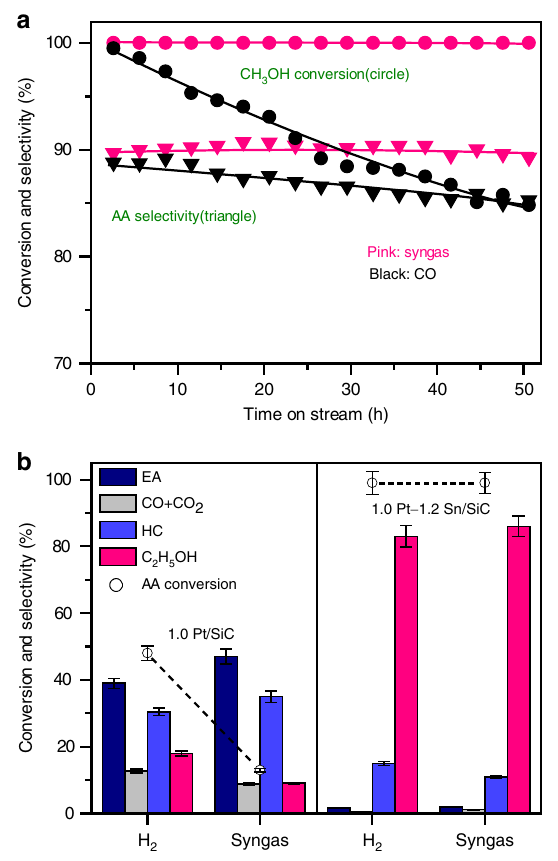
Fig. 5 Catalyst compatibility in syngas stream. a Catalytic performances of H-MOR – DA – 12MR for methanol carbonylation in CO and syngas streams. AA: acetic acid. Reaction conditions: H-MOR – DA – 12MR, 1.0 g; P = 5.0 MPa; T = 583 K; F (CH = 1.48 mmol h − 1 ; F (95%CO – 5%Ar) or 3 OH) F (48%CO – 48%H – 4%Ar) = 12 or 24 mL min − 1 . b Catalytic performances 2 of Pt/SiC and Pt – Sn/SiC for acetic acid hydrogenation in H 2 and syngas streams. EA: ethyl acetate; HC: hydrocarbons; AA: acetic acid. Reaction conditions: Pt/SiC or Pt – Sn/SiC, 0.66 g; P = 5.0 MPa; T = 583 K; F (AA) = 1.05 mmol h − 1 ; F (H 2 ) or F (48%CO – 48%H 2 – 4%Ar) = 12 or 25 mL min − 1 ; time on stream, 20 h. The experiments in each case were performed for three times. The error bar represents the relative deviation, which is within